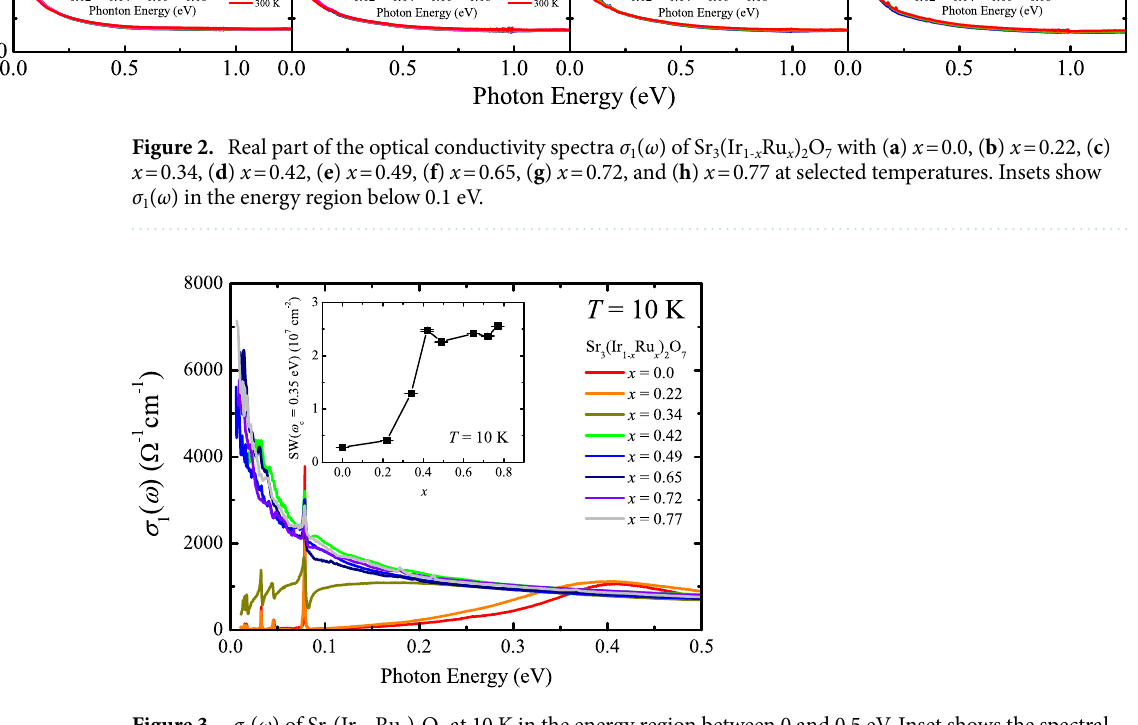
Figure 3. σ 1 ( ω ) of Sr 3 (Ir 1- x Ru x ) 2 O 7 at 10 K in the energy region between 0 and 0.5 eV. Inset shows the spectral weight of the Sr 3 (Ir 1- x Ru x ) 2 O 7 compounds obtained by integrating σ 1 ( ω ) up to 0.35